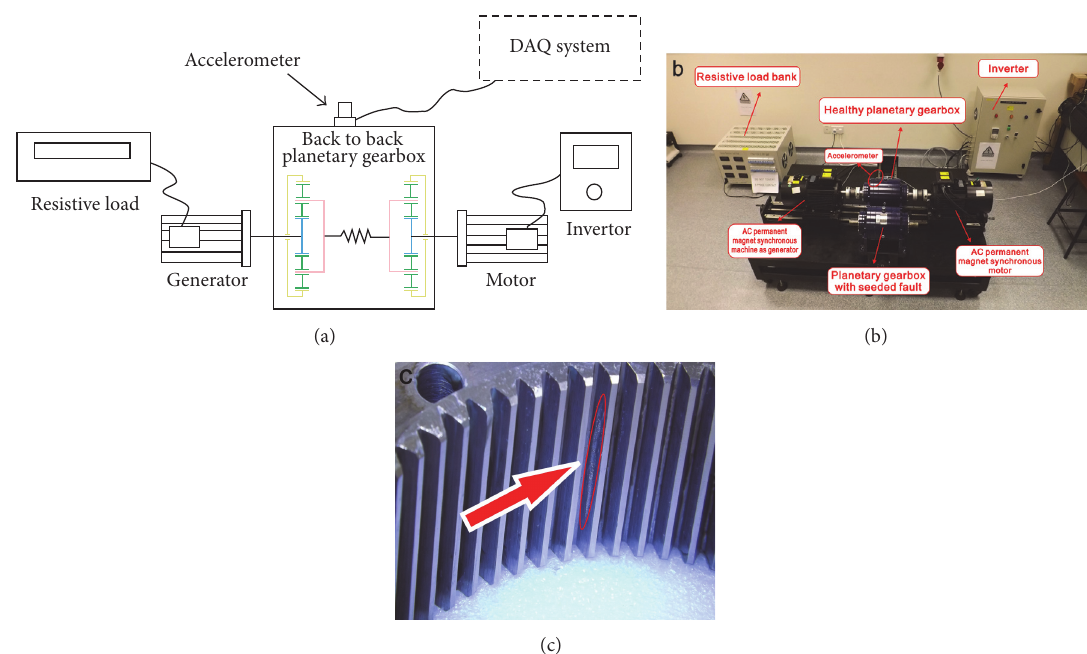
Figure 11: (a) Schematic of the test rig; (b) planetary gearbox test rig; and (c) seeded gear fault on the annulus gear.